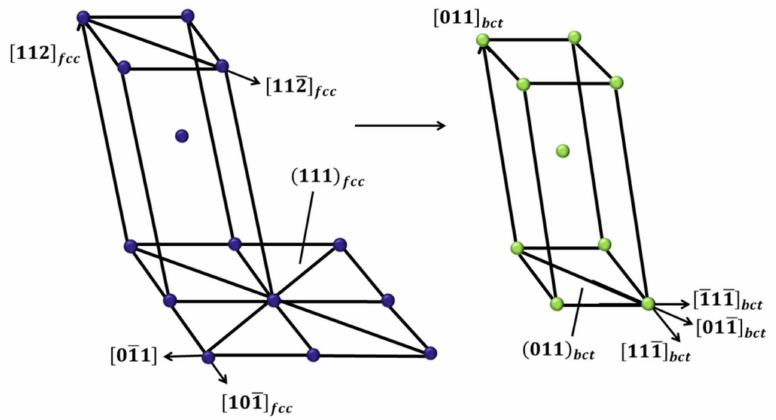
Figure1. SchematicdescriptionofthefirstsheardeformationintheKurdjumov–Sachs(K–S)relationship. The shear deformation is on the (111) fcc plane along the [112] fcc